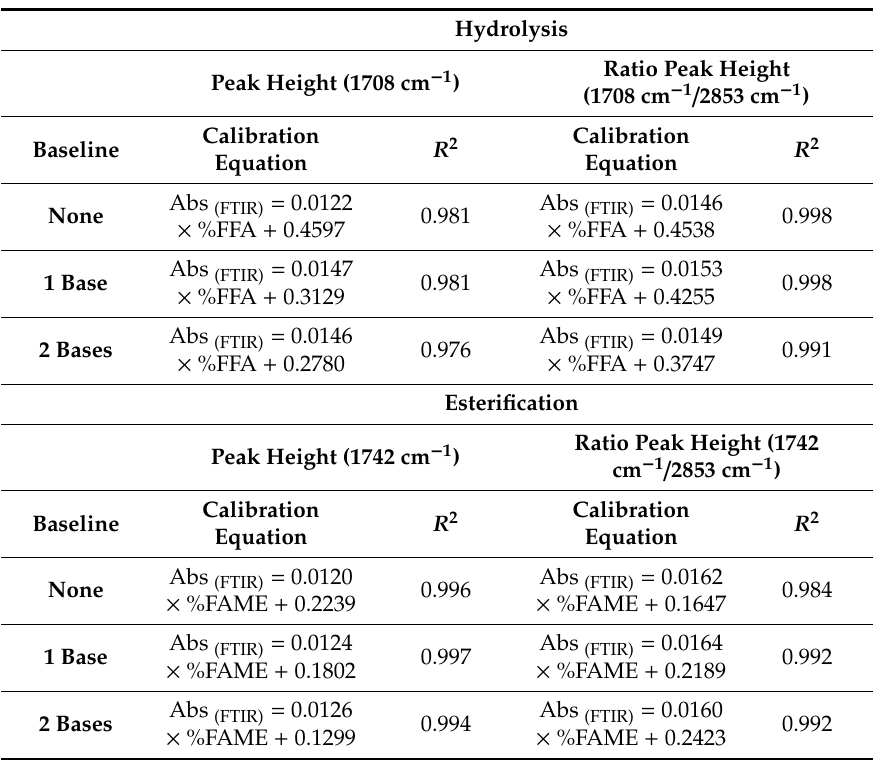
Table 1. Linear equations for monitoring hydroesterification (hydrolysis and esterification) of the acid oil from soapstock by FTIR.